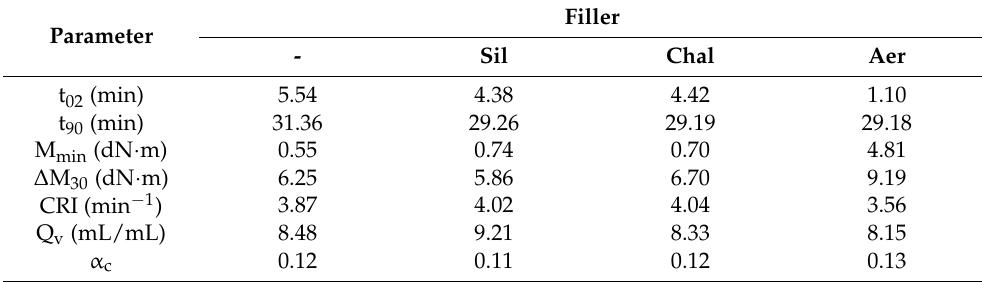
Table 2. The cross-linking characteristic of the unfilled or filled composites cured at 160 ◦ C.